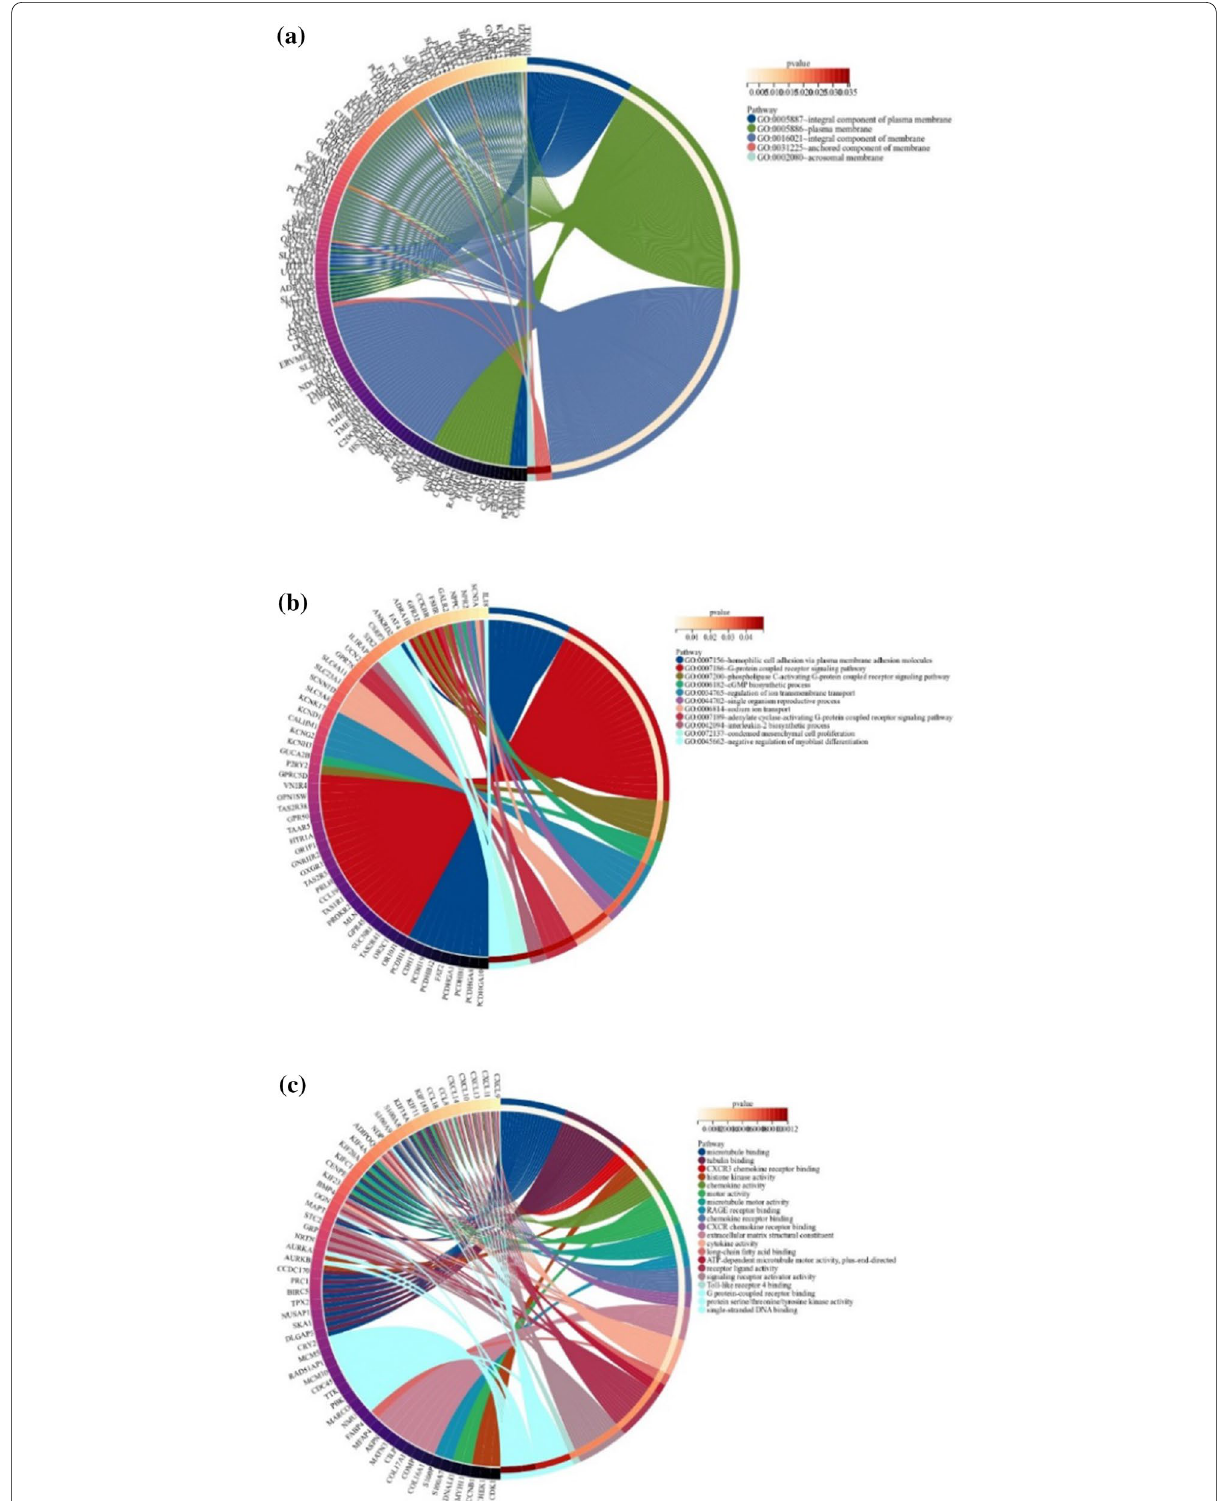
Fig. 2 (See legend on previous